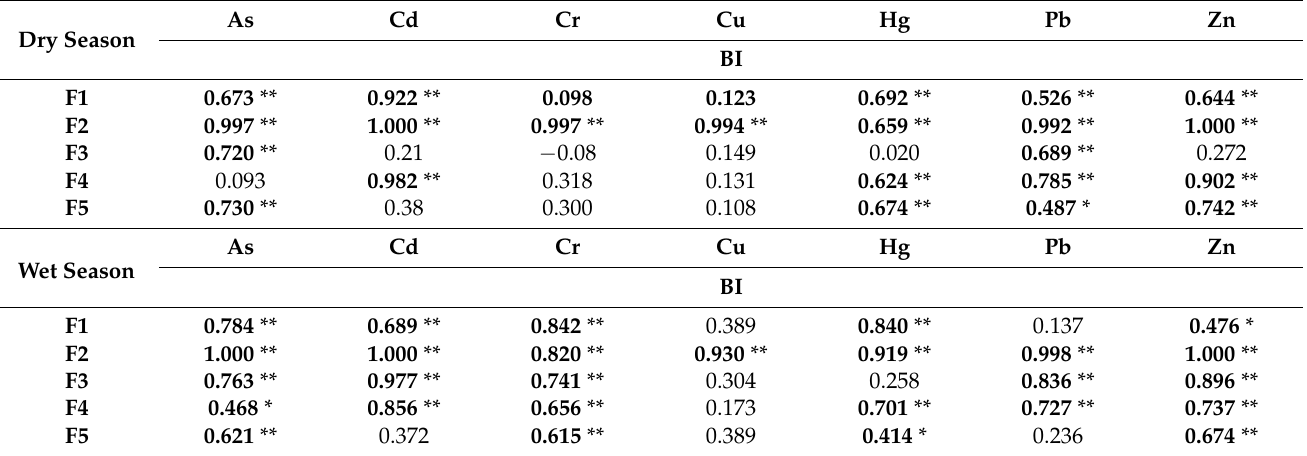
Table 3. The correlations between the bioavailability and speciations of metals in dry season and wet